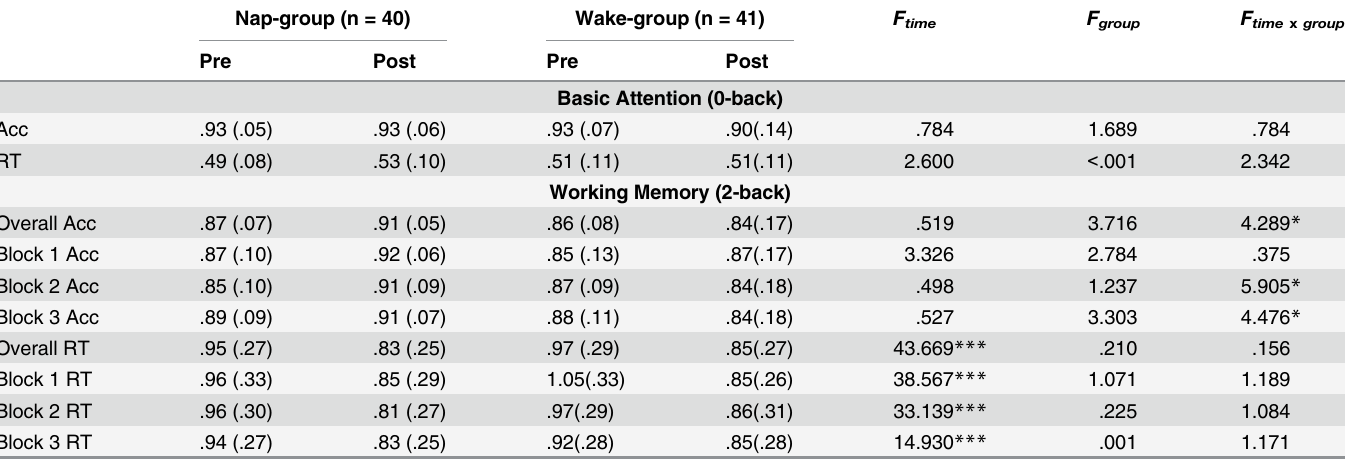
Table 4. Between-group comparisons on basic attention and working memory